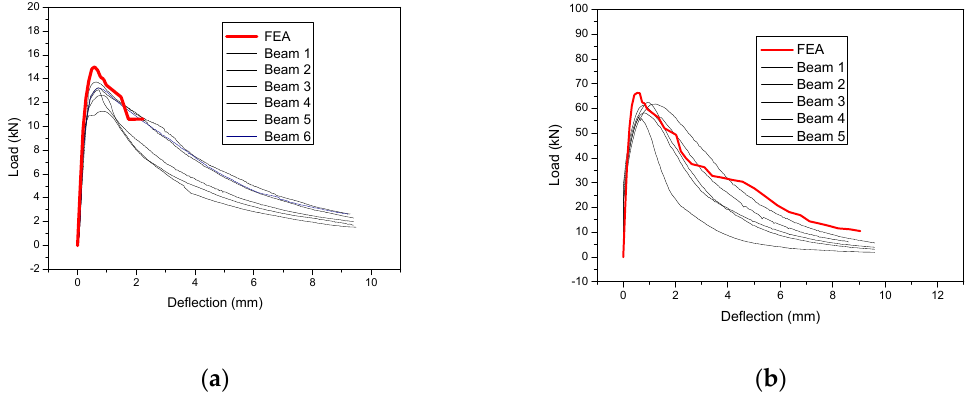
Figure 13. Load deflection results: Numerical vs. Experimental for UHPFRC-1 prisms with ( a ) 25 and ( b ) 100 mm depth values.